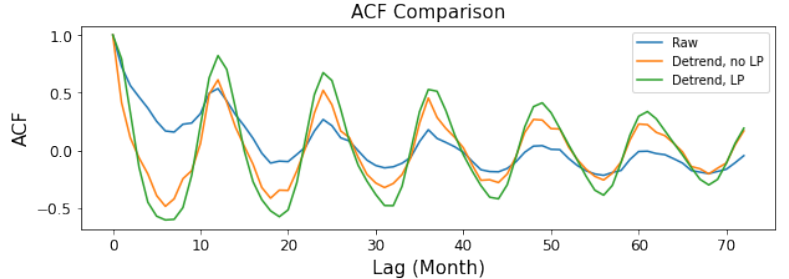
Figure 10. ACF with a comparison at different preparation stages.